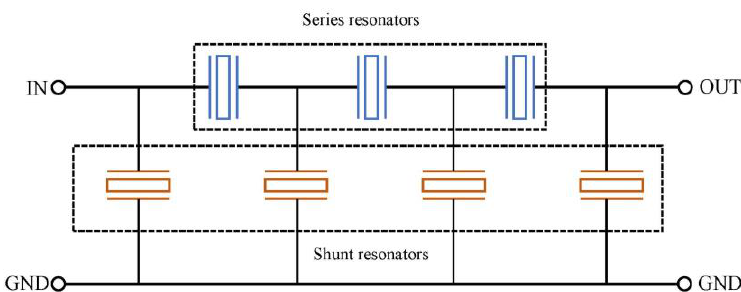
Figure 9. Ladder-type configuration filter for BAW and 1-port SAW devices.